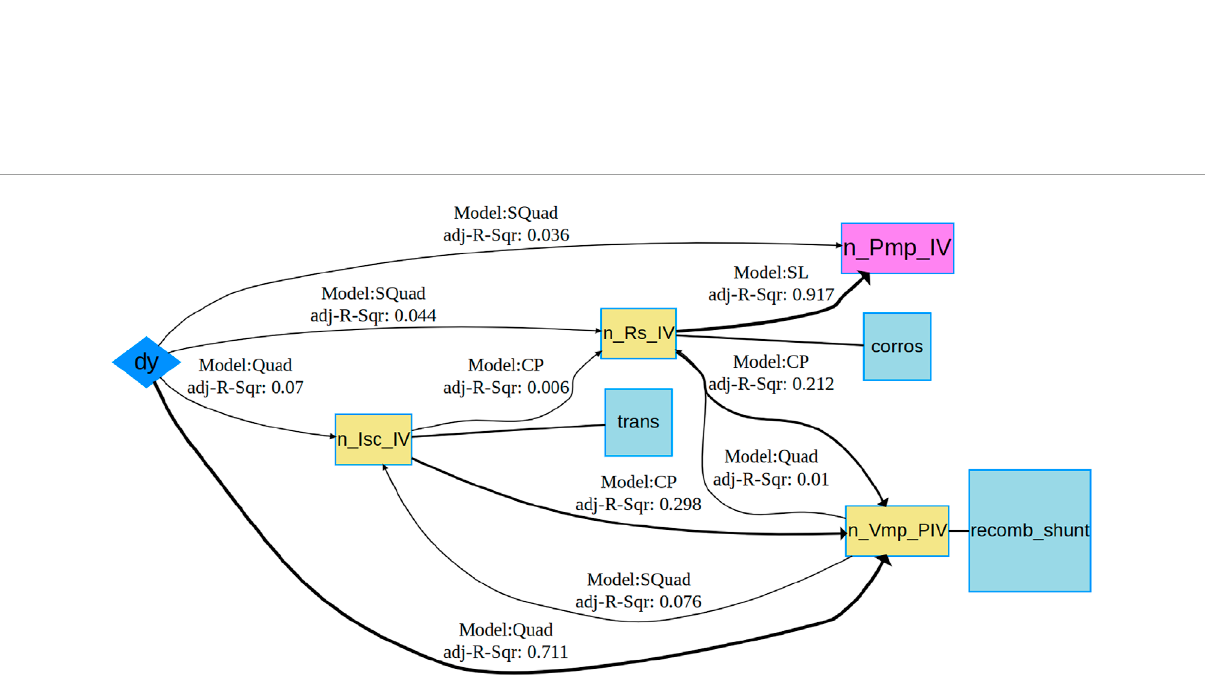
FIGURE 5 < S | M | R > model constructed using Markovian model for the variant DG with POE encapsulation made by manufacturer B and exposed in mDH + FSL conditions. dy is exposure time (stressor), n P mp , IV is maximum power, which is the response. n I sc , IV indicates short-circuit current, n R s , IV indicates series resistance and n V mp , PIV indicates voltage at maximum power (IV means that the measurement is from current-voltage data whereas PIV means it is a Suns - V oc measurement). The blue boxes indicate the degradation mode that the variable tracks: n I sc , IV tracks optical transmission loss, n R s , IV monitors corrosion and n V mp , PIV tracks recombination and